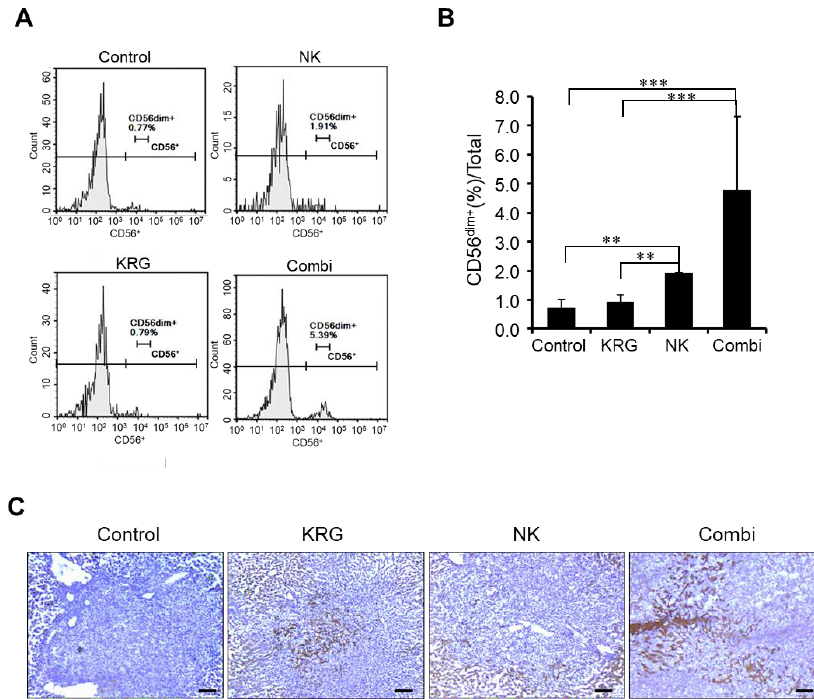
Figure 3. Detection of circulating NK cells in an experimental metastasis model. ( A ). CD56 levels measured via FACS analysis. ( B ). Ratio of CD56 dim+ cells. Data are expressed as the mean ± standard deviation ( n = 3/group). **, p < 0.01; ***, p < 0.005. (two-way ANOVA with Tukey’s post hoc test) ( C ). CD56 positive cells in liver tissues. Brown dots represent CD56 positive cells. Scale bar, 100 μm.